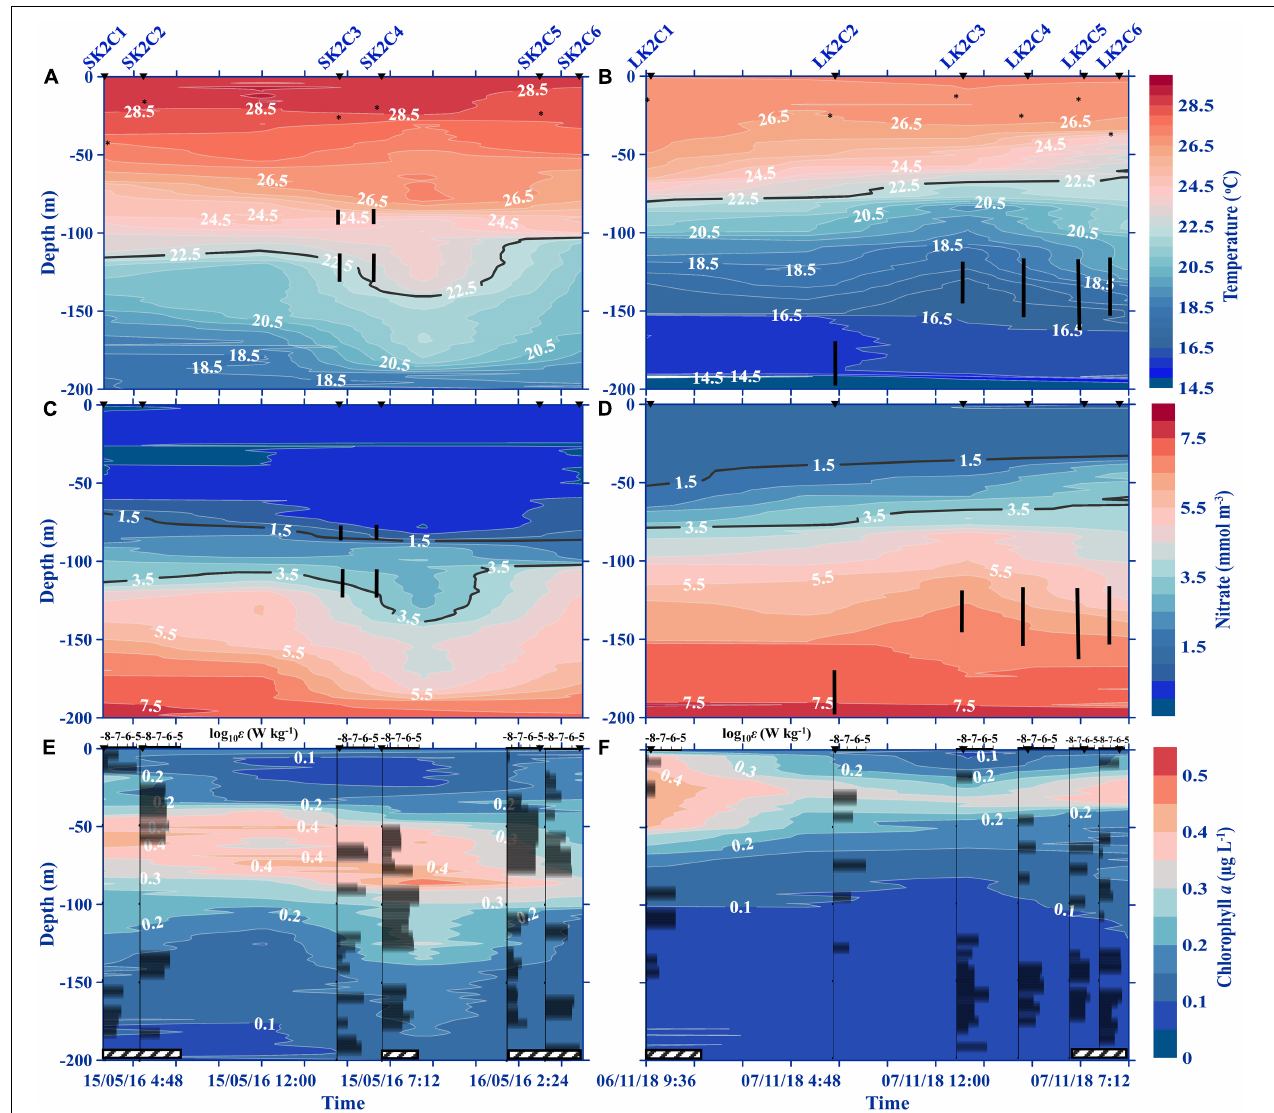
FIGURE 3 | Time-series depth contours of temperature (A,B) , nitrate (C,D) , and Chl a (E,F) during the SBC (2016; left panels) and the LBC (2018; right panels) at station K2. The cast and station numbers denoted above the top graph apply to all panels below. Asterisks on the temperature panels denote the mixed layer depths. The black vertical lines on (A–D) indicate KH billow depths in periods where they appeared. The black contour lines illustrating isotherms and nitrate isolines correspond to those discussed in the text (A–D) . The black bars on the chlorophyll profiles represent the TKE dissipation rates [log 10 ε (W kg − 1 )]. Hatched bars along the x -axis indicate nighttime